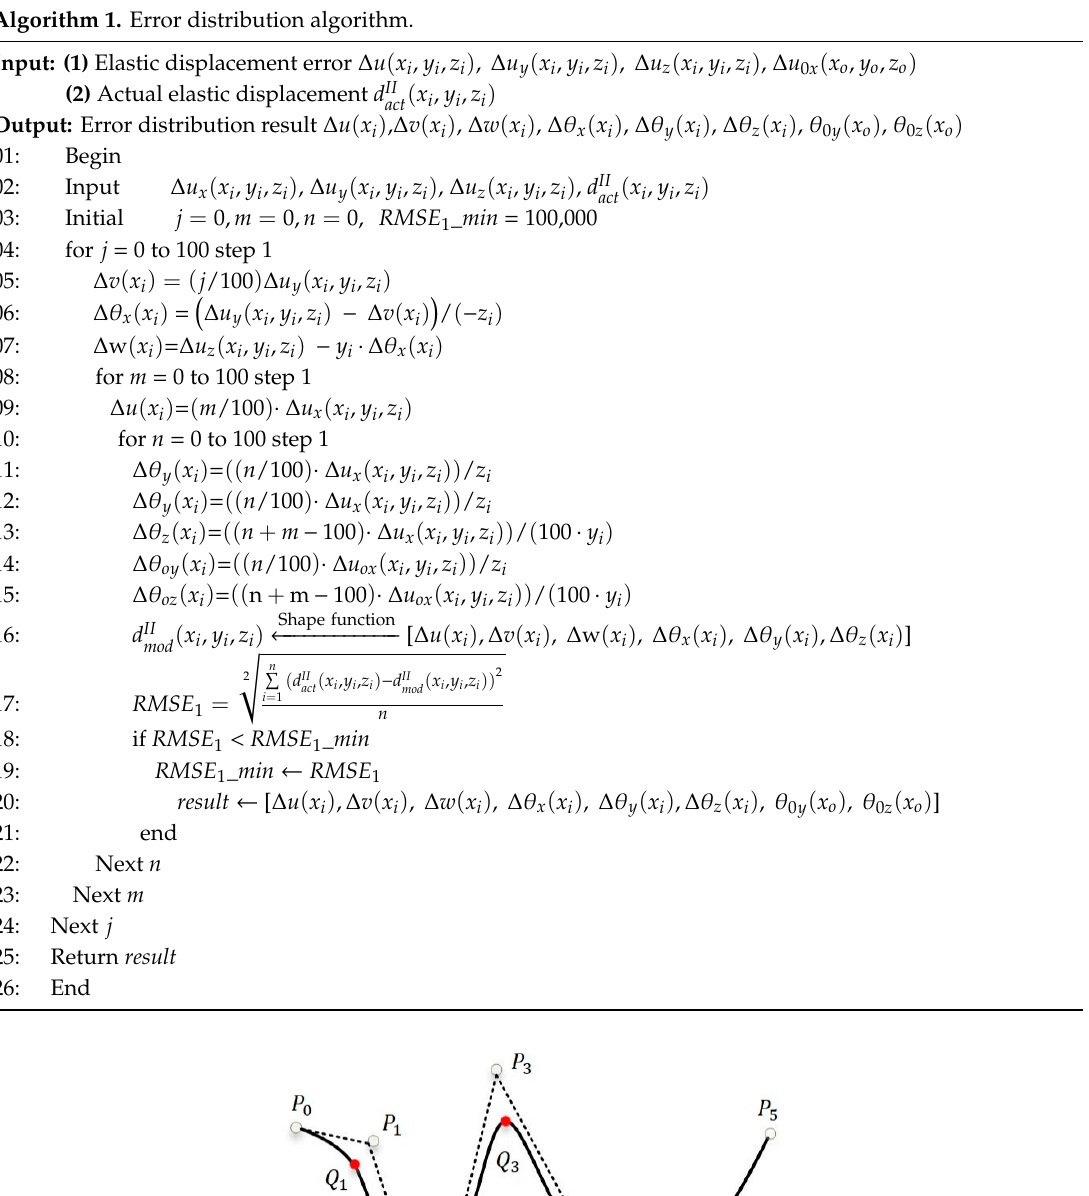
Algorithm 1. Error distribution algorithm.